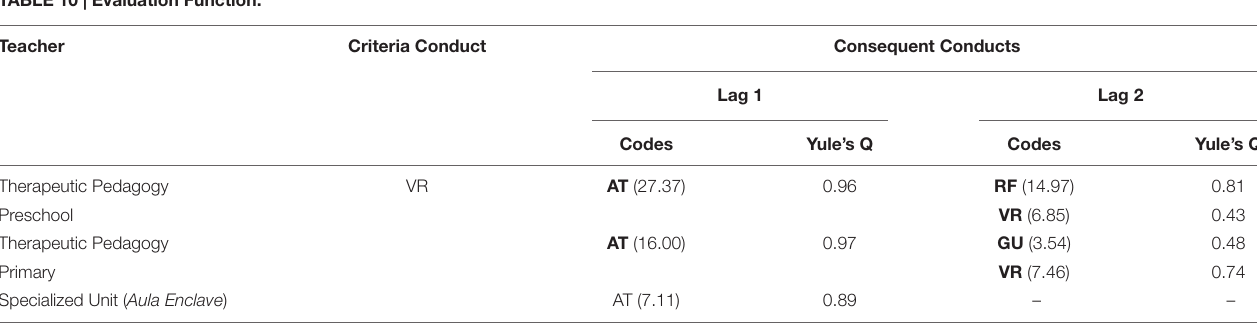
TABLE 10 | Evaluation